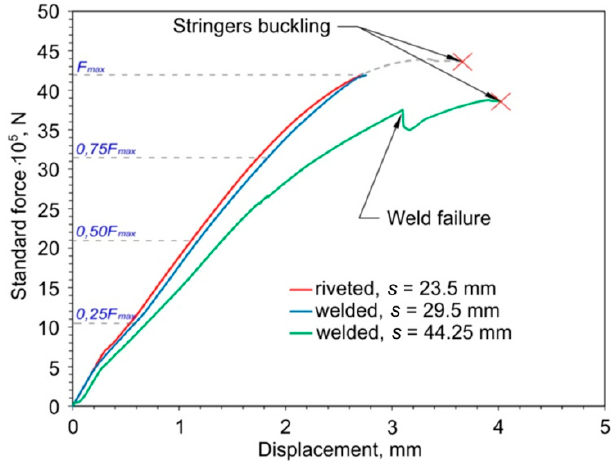
Figure 3. Force vs. displacement relationship for the variants of the panels analyzed.